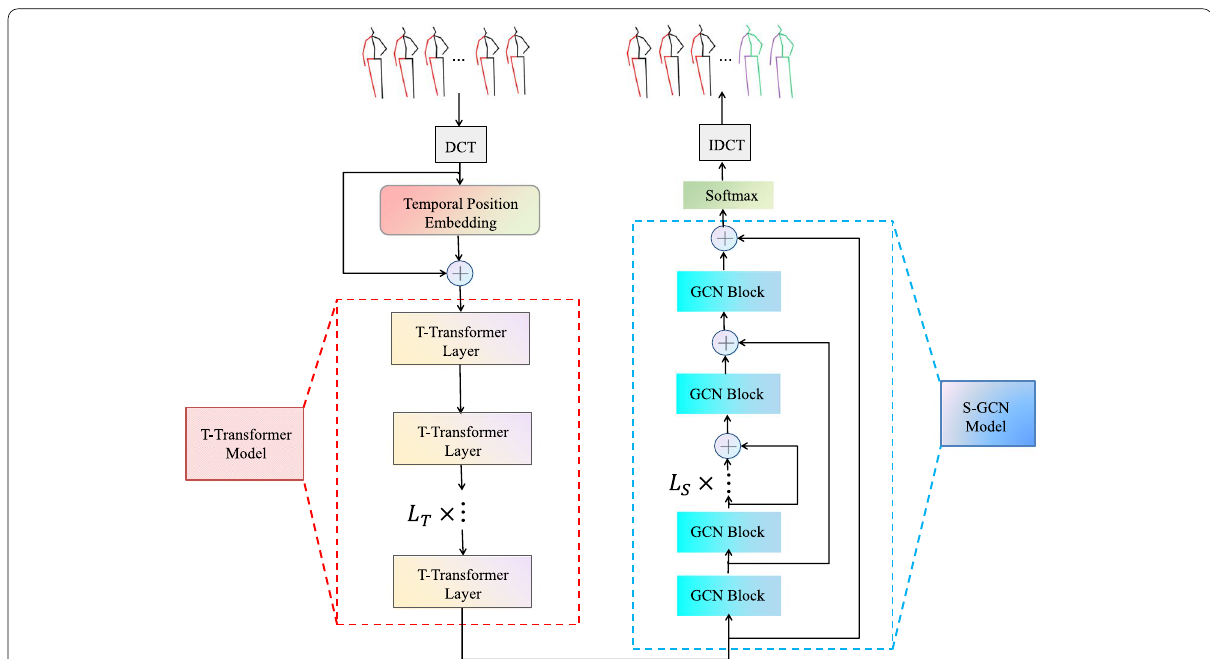
Fig. 1 Overview of STTG-Net network